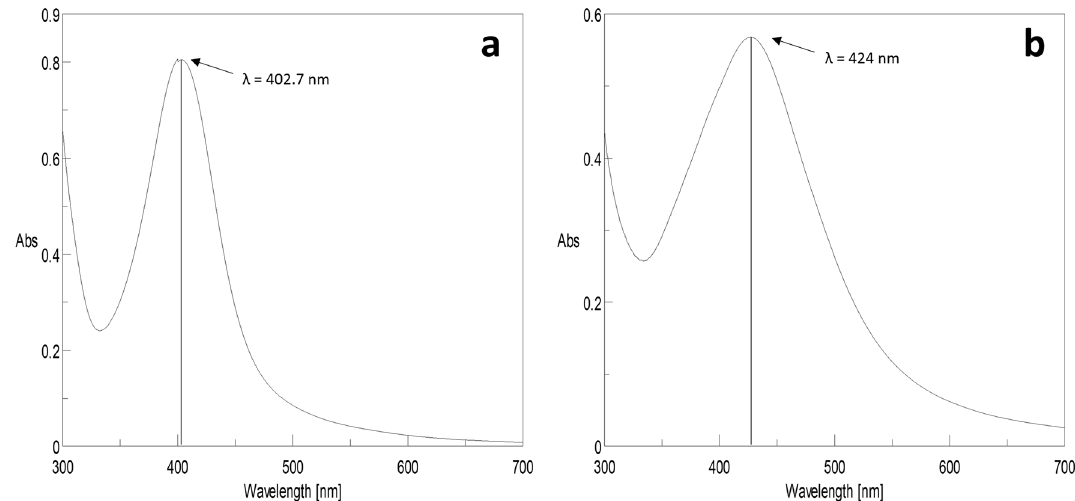
Figure 1. UV–Vis spectra of ( a ) cinnamon AgNPs and ( b ) ginger